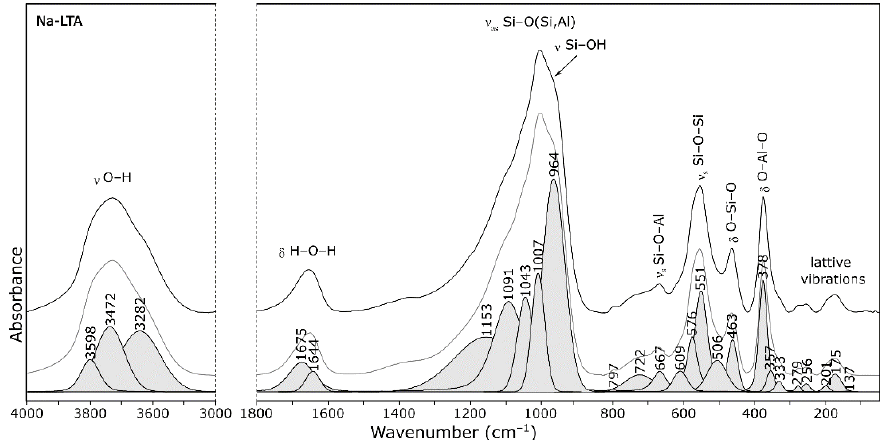
Figure 3. FT-IR spectrum of zeolite Na-A.